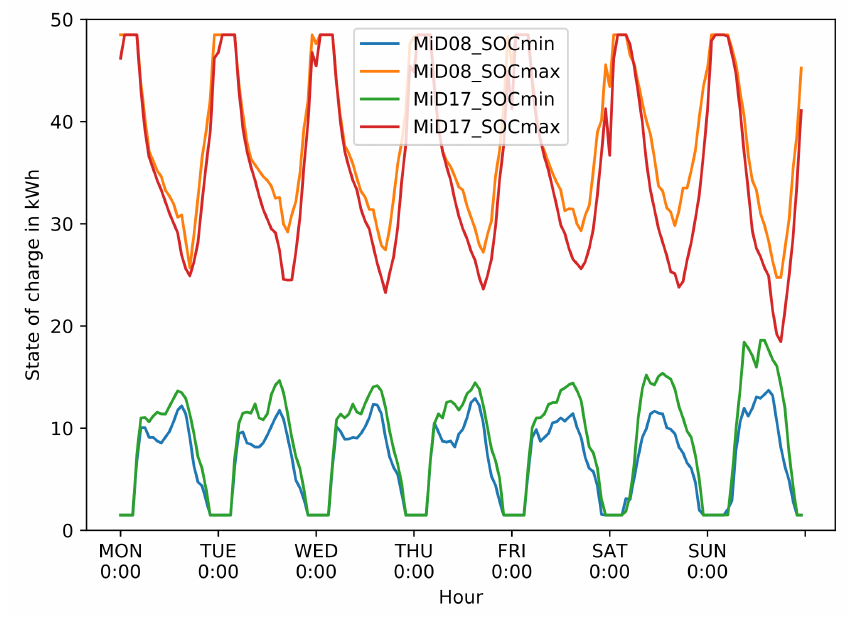
Figure 6. SoC min and max profiles of MiD08 and MiD17. Profiles are based on single-day min and max profile calculation and merged for this plot. For details, see Section 2.1.4. A 50 kWh battery is assumed for this case